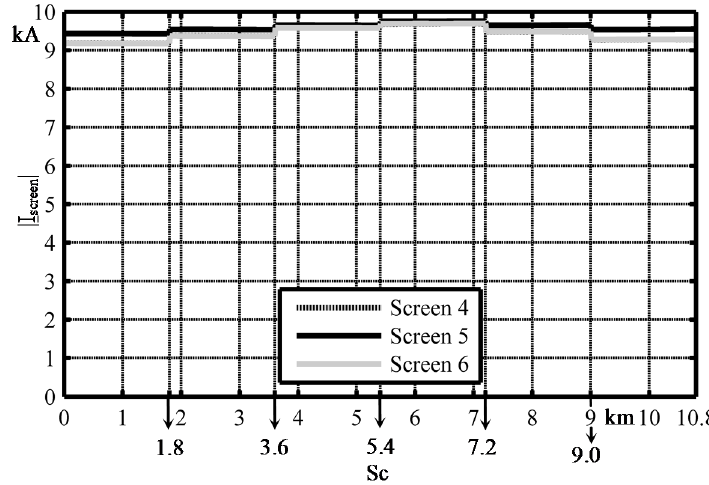
Figure 3. Faulted UGC: screen current magnitudes along the line CB with phase transpositions (PTs); FAULT at midline.